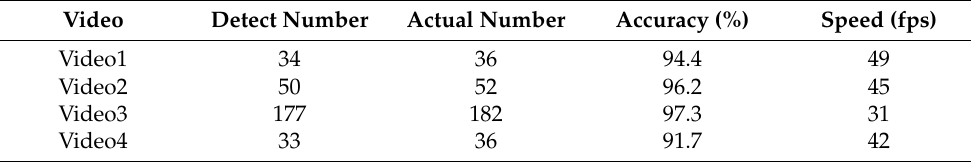
Table 6. Results of testing the proposed algorithm on several video sequences.